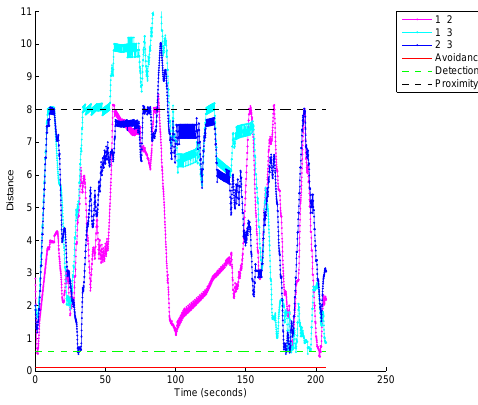
Fig. 3. Distances between robot pairs.